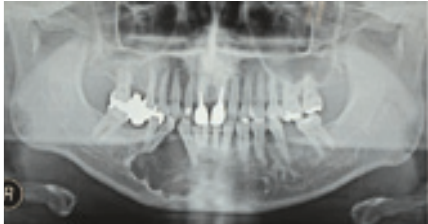
Figure 2: A panoramic radiograph showing a well-defined large radiolucent lesion in the right